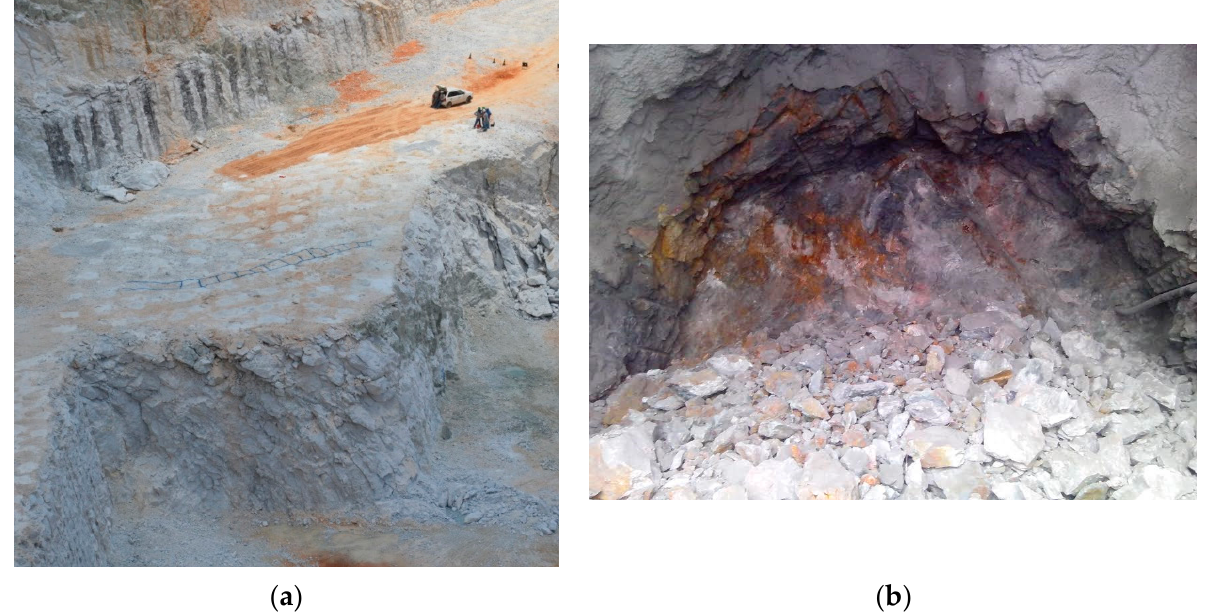
Figure 2. ( a ) Examples of ordinary blasts: above, production blast in a limestone quarry, Brazil [3]; ( b ) tunnel face after a blast: the poor quality of the contour obtained is noticeable [4].